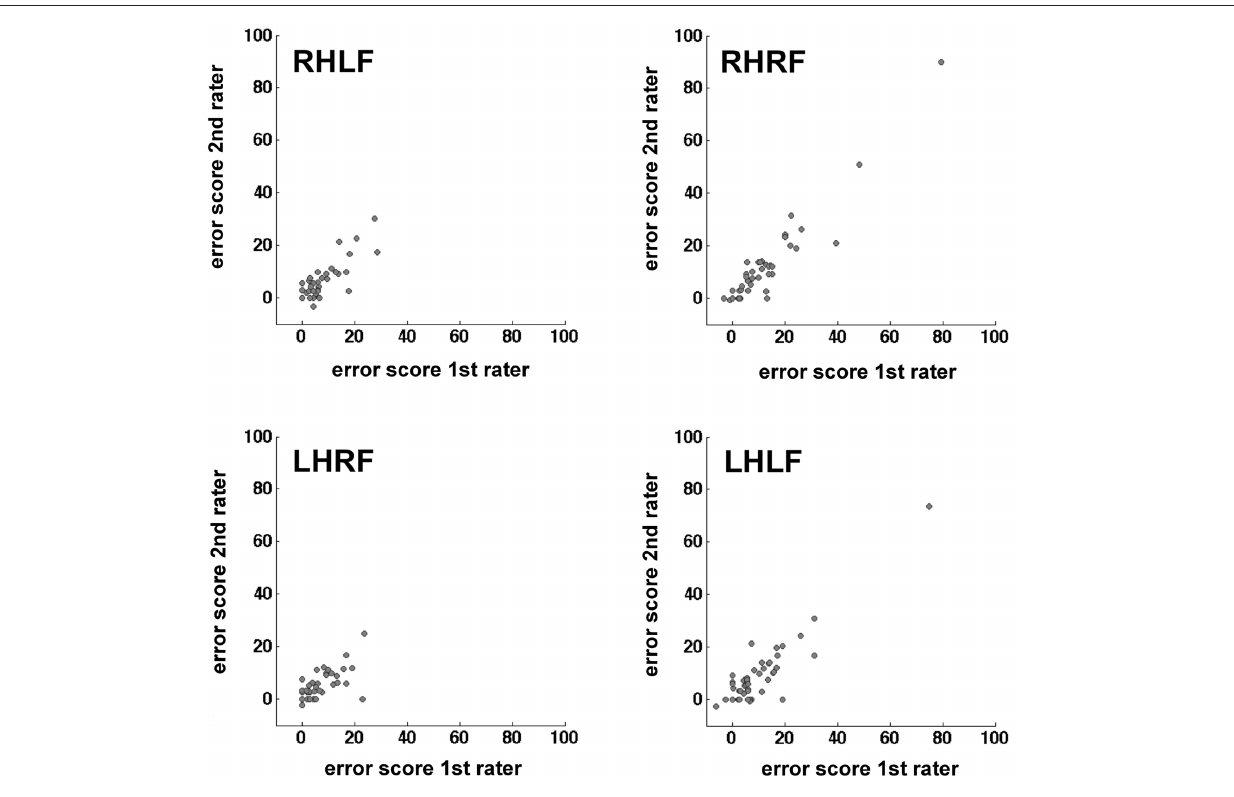
for all hand/field combinations ranged between r = 0 . 718 and r = 0 . 947 ( Table 5 ). The scatter plots of the error scores displayed extreme values in two of the four conditions ( Figure 4 ).